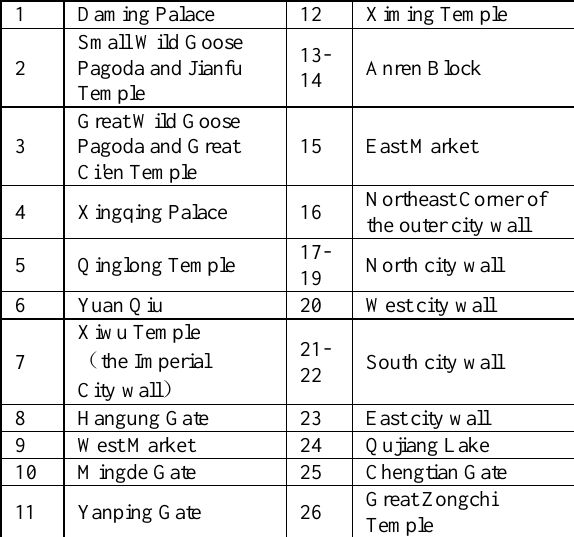
Table 2. Traces in Chang'an City of Tang Dynasty （ Remains